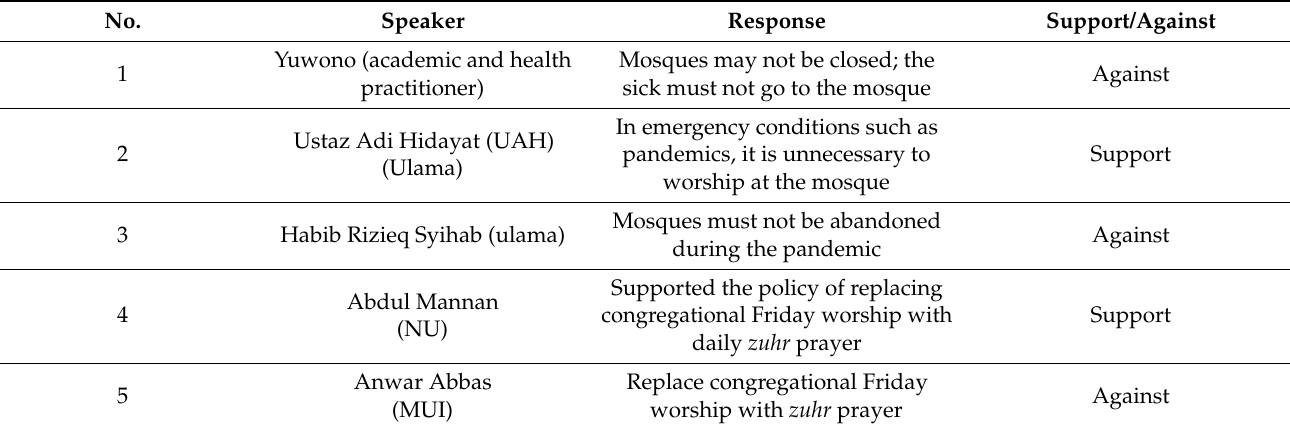
Table 2. Public Discourse regarding Worship Restrictions during the COVID-19